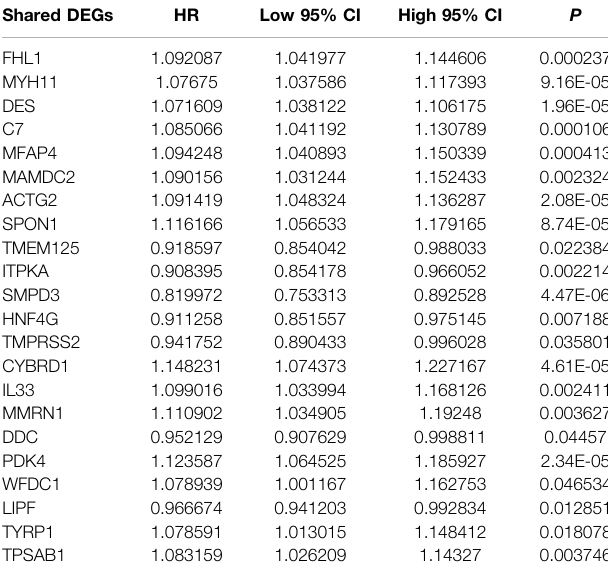
TABLE 1 | Identi fi cation of 22 prognosis-related shared DEGs in GC through univariate Cox regression models. Shared DEGs